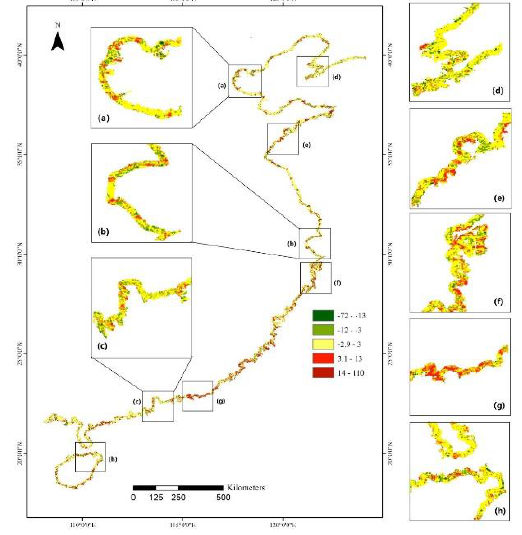
Figure 10. China’s coastal luminous radiation change from 2015 to 2019. (a) enlarged map of the Beijing-Tianjin-Hebei region (b) magnified map of the Yangtze River Delta region (c) magnified map of the Pearl River Delta